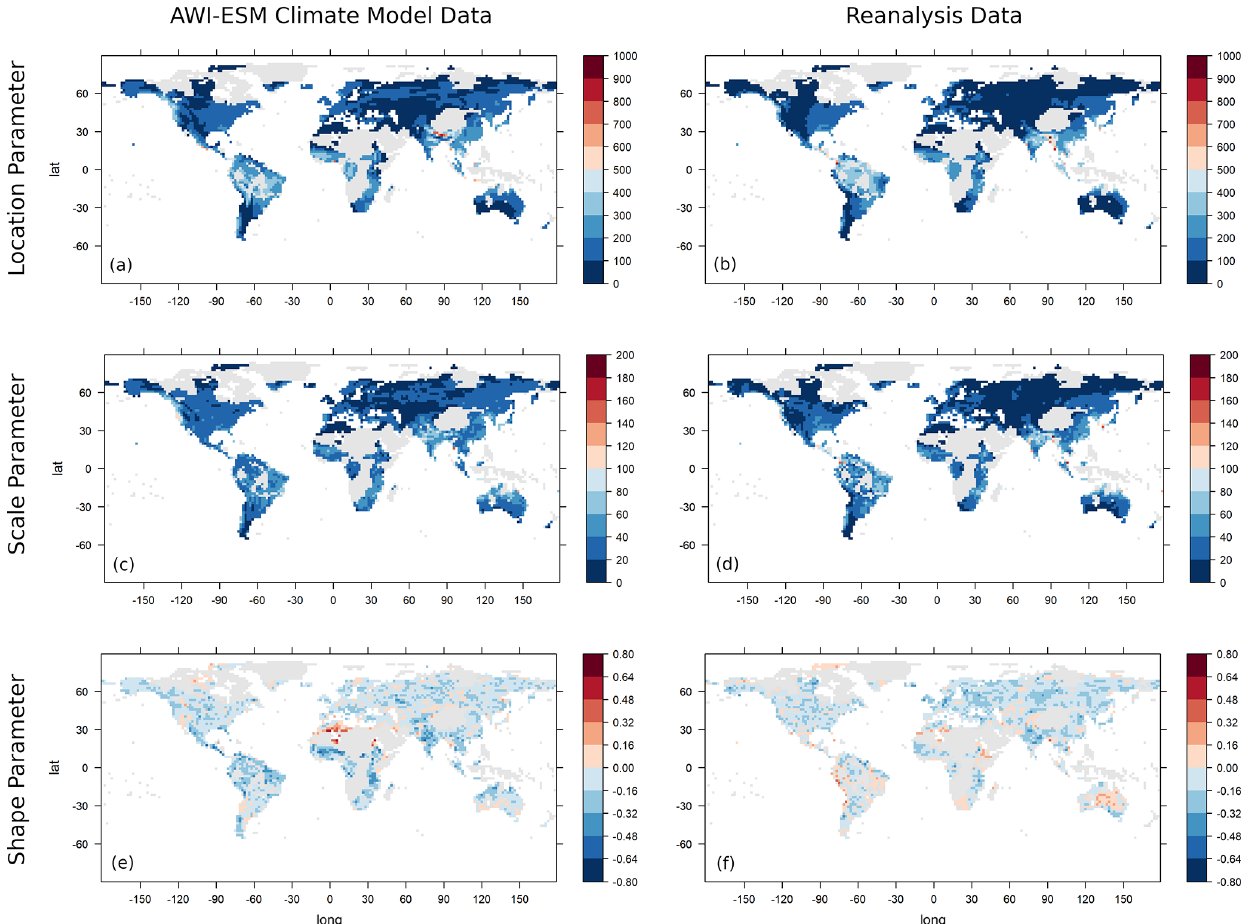
Figure 4. The estimated GEV parameters location (a, b) , scale (c, d) and shape (e, f) for the AWI-ESM climate model data (a, c, e) and reanalysis data (b, d, f) . Values exceeding the scale limits are truncated. Values are given in millimetres per